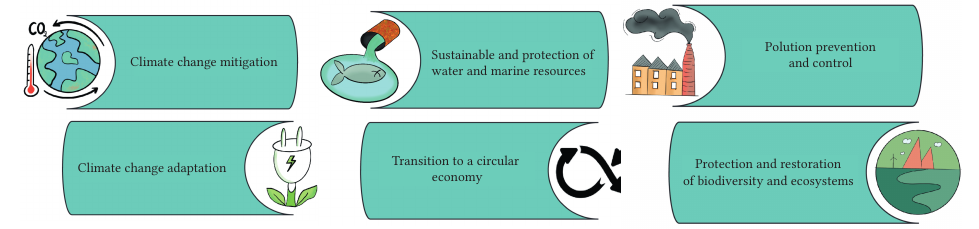
Figure 1. European Union taxonomy areas to be assessed in